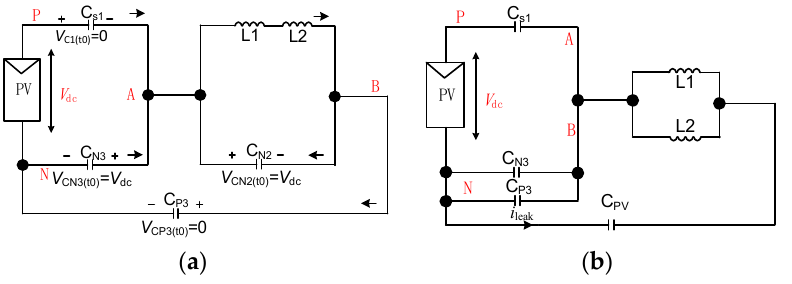
Figure 2. Transient charging and discharging operation of H5. ( a ) Transient operation [53]; ( b ) Equivalent circuit [53].